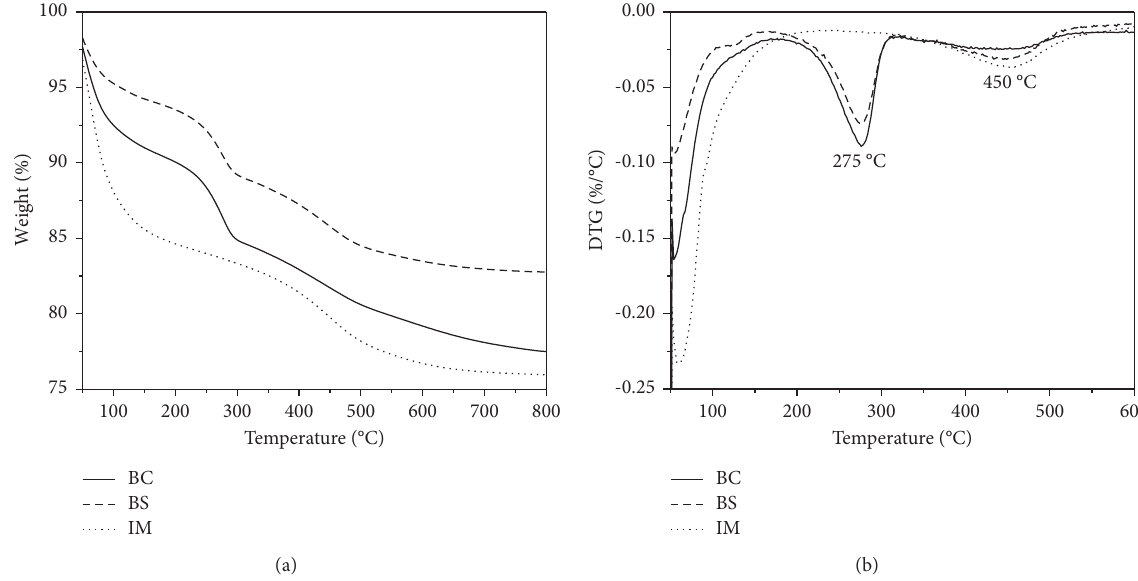
Figure 5: TGA measurements of the sample powders (PAD) for the three types of rocks. (a) TGA thermogram. (b) DTG